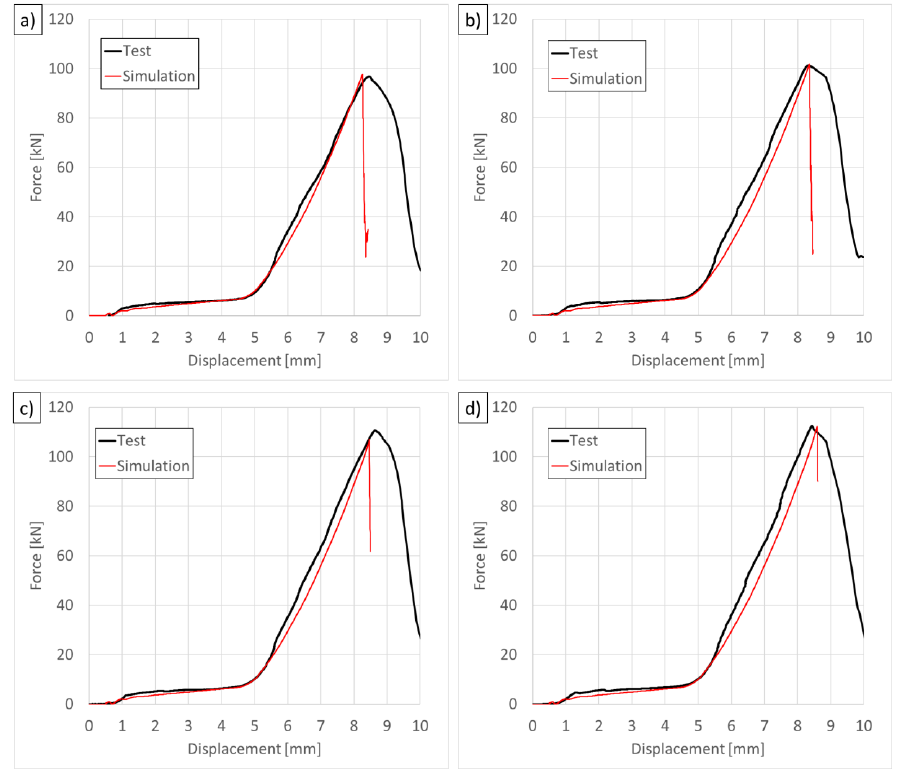
Figure 16. Force vs. displacement chart showing test vs. simulation curves at v = 10 mms − 1 and ( a ) 40% SoC, ( b ) 60% SoC, ( c ) 80% SoC, and ( d ) 100% SoC. The increment of increased failure strain is set to 0.006 [-] to model the different fail- ure force.